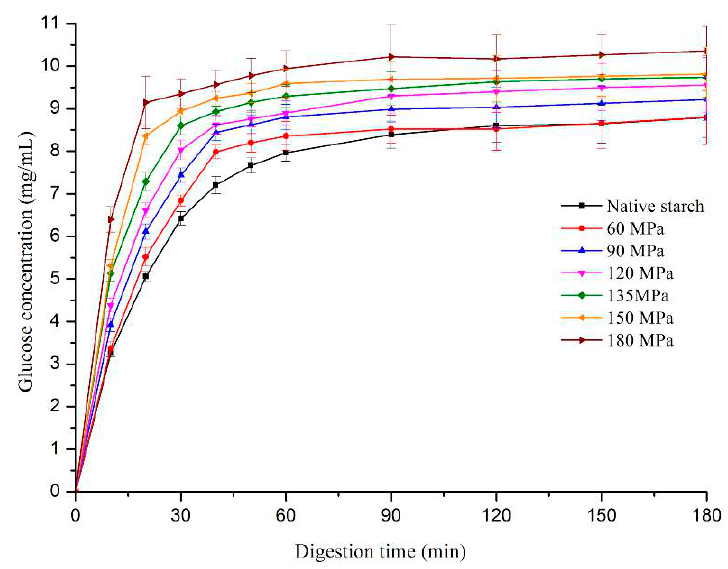
Figure 6. Digestion efficiency of native and pressurized LS.